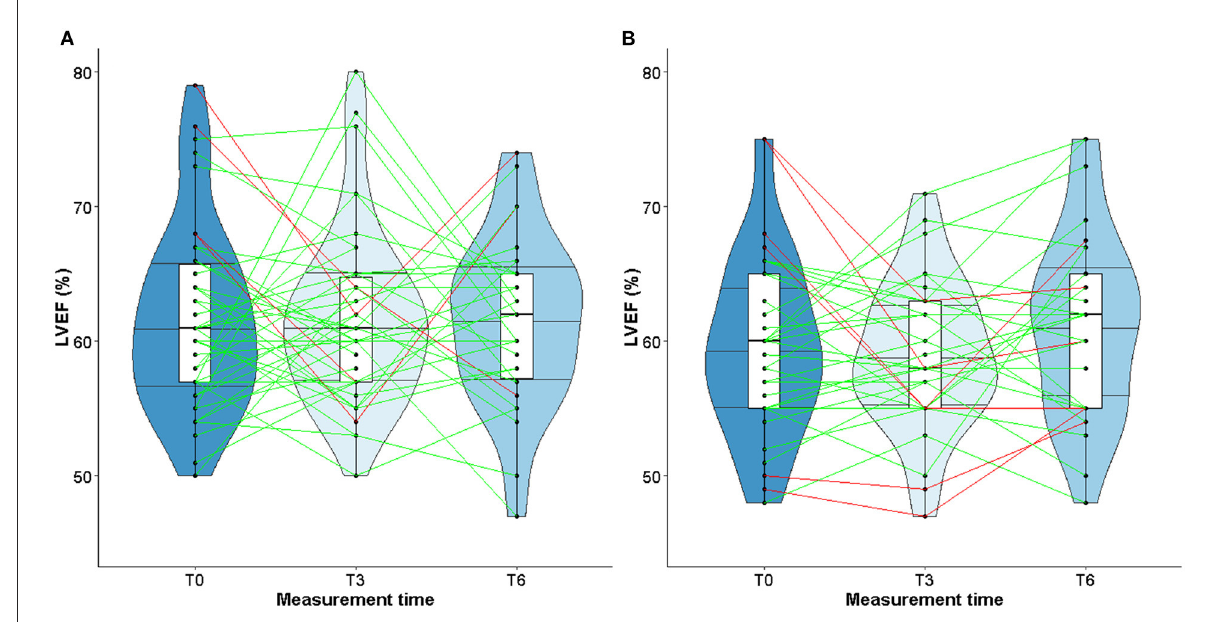
FIGURE2 Violin plot for evolution of LVEF in TG (A) and CG (B)